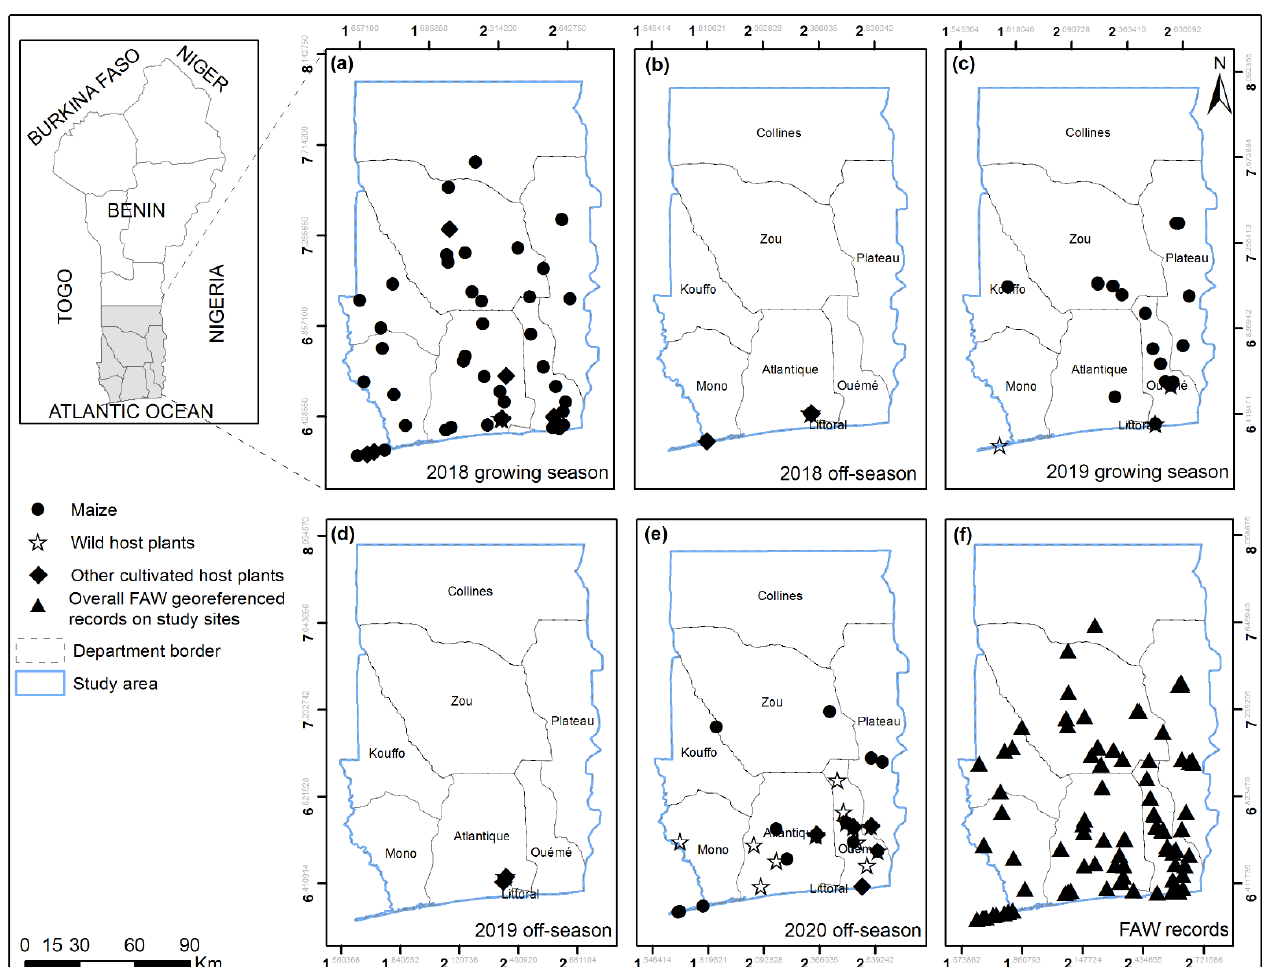
Figure 1. FAW occurrences on maize and alternative host plants during ( a , c ) growing seasons and ( b , d , e ) off-seasons for the years 2018, 2019 and 2020, and ( f ) overall FAW georeferenced records on study sites in southern and central Benin.